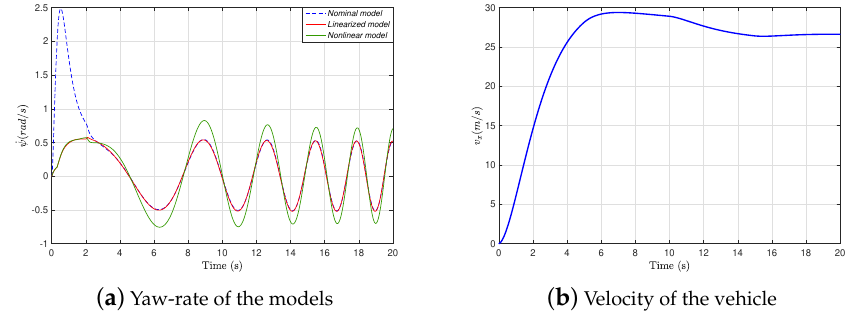
Figure 7. Validation of the neural